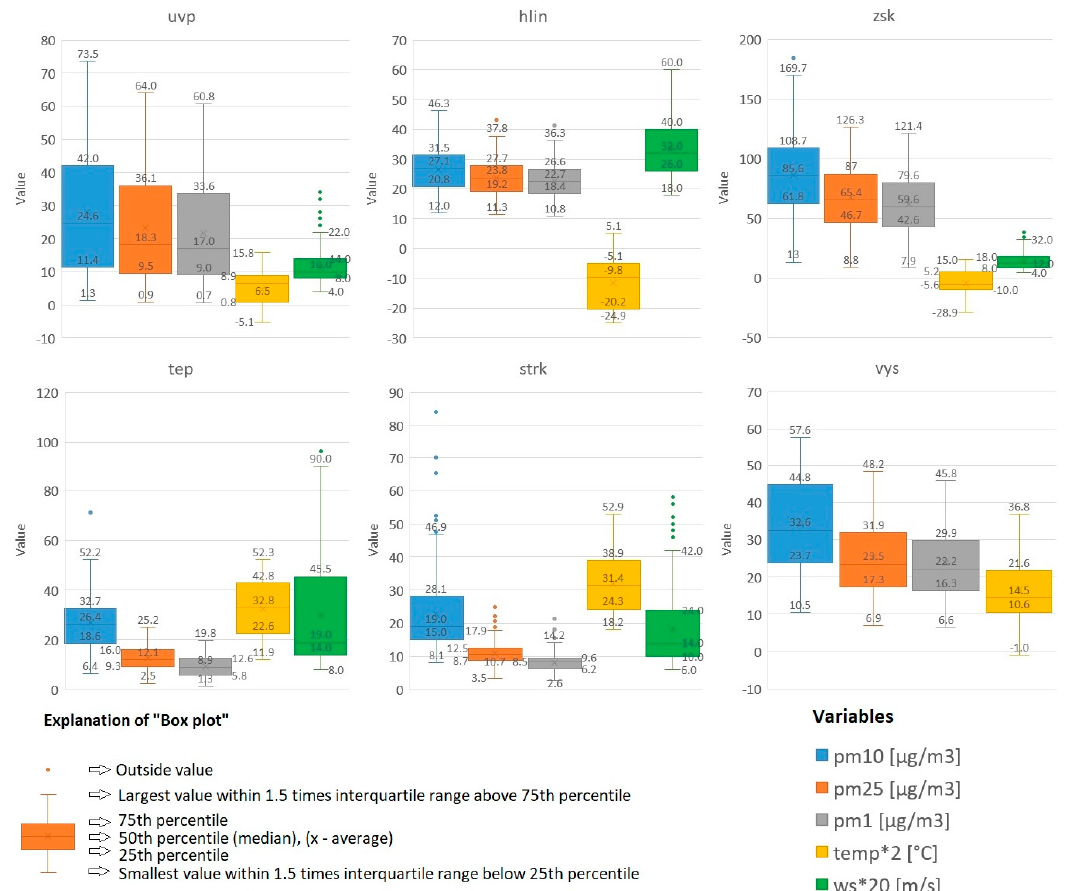
Figure 2. “Box plot” showing the concentration of particulate matter and meteorological parameters during air quality measurements in Žilina city (temp—temperature, ws—wind during air quality measurements in Žilina city (temp—temperature, ws—wind speed). The highest concentrations of PM were measured at the monitoring station on Komenského Street. The average PM 10 concentration for the whole measurement period was 86.0 ± 122.0 µg/m 3 ,